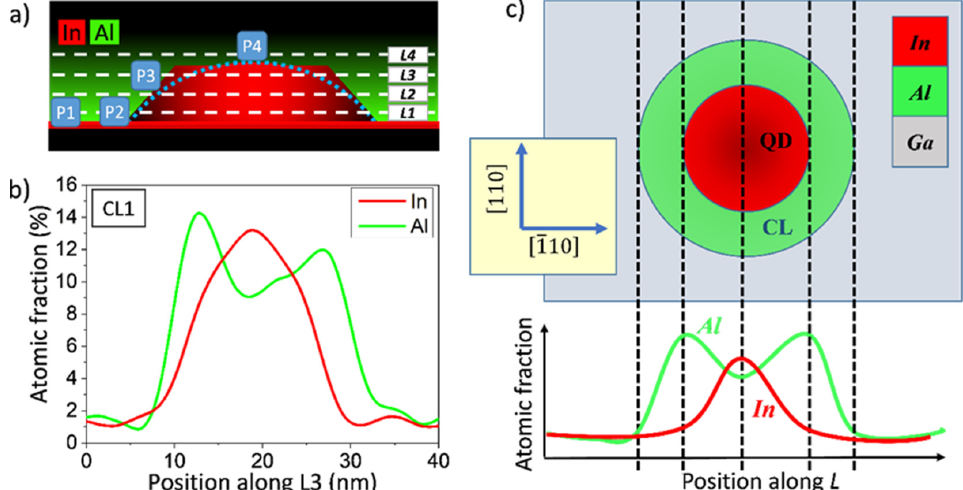
Figure 7. ( a ) Scheme of a QD capped by an AlAs layer. L1 to L4 are directions parallel to the growth plane where the compositional profiles are taken. P1 to P4 are the positions for punctual measurements. ( b ) Experimental compositional profiles along the line L3 for a QD in the CL1 layer. ( c ) Plan view of a slide of the QD capped with AlAs and its correspondence with the theoretical composition profiles for In and Al.